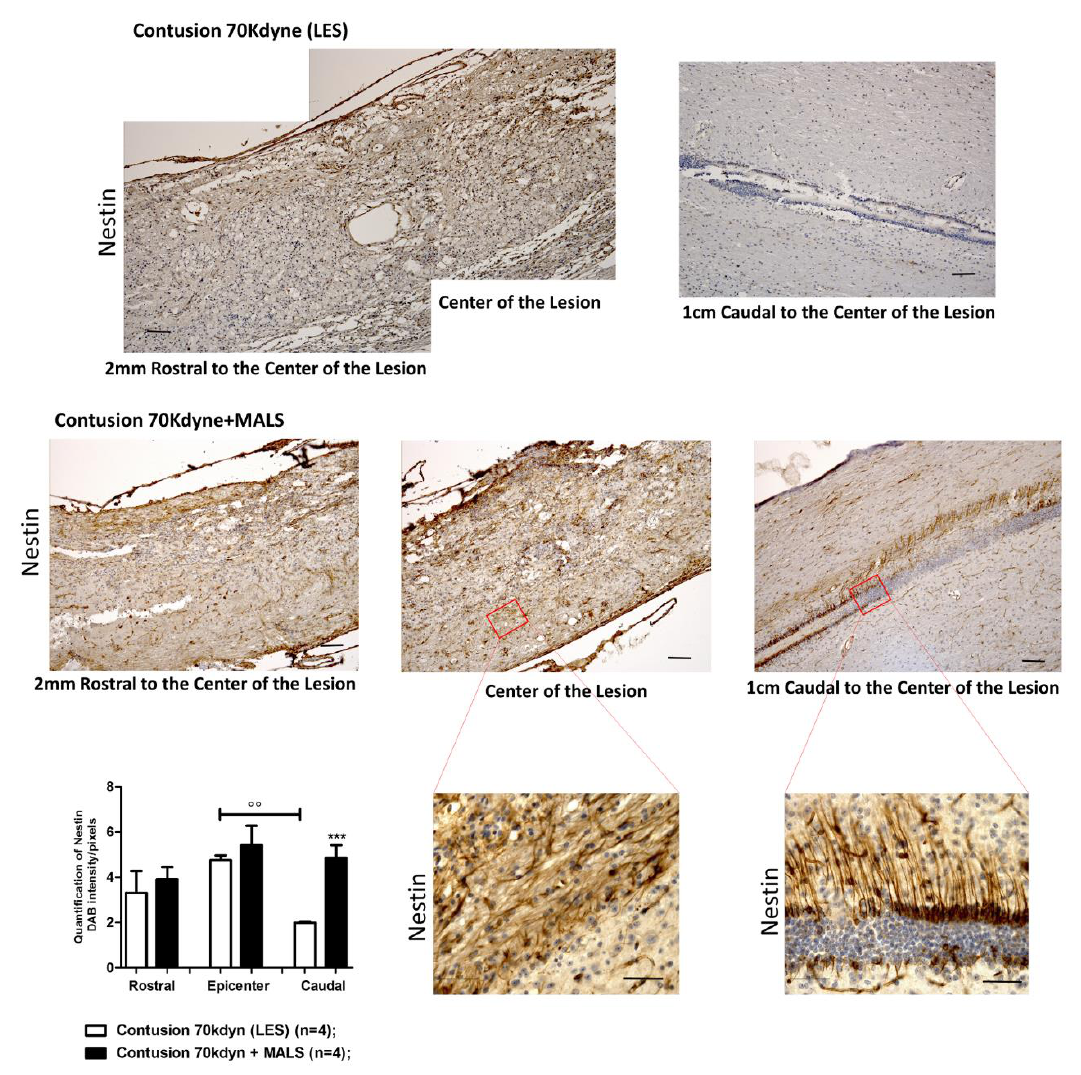
Figure 5. MALS engraftment leads to increased neurogenesis in the grafted cord. The image shows an increase in neural precursor cells at the lesion site of MALS transplanted animals, as demonstrated by the increase in Nestin positive cells. The graph reported shows the quantification of the distribution of Nestin’s expression along the grafted cord. Data is expressed as mean of twelve di ff erent fields (n = 4 mice; 3 fields / mouse). Values represent mean ± SD. We determined the statistical di ff erences by means of ANOVA test followed by Bonferroni’s post-test. *** p < 0.001 vs. LES; ◦◦ p < 0.01 of LES caudal vs. LES epicenter. Symbols ($; ◦ ;*) indicate the corresponding area in Figure